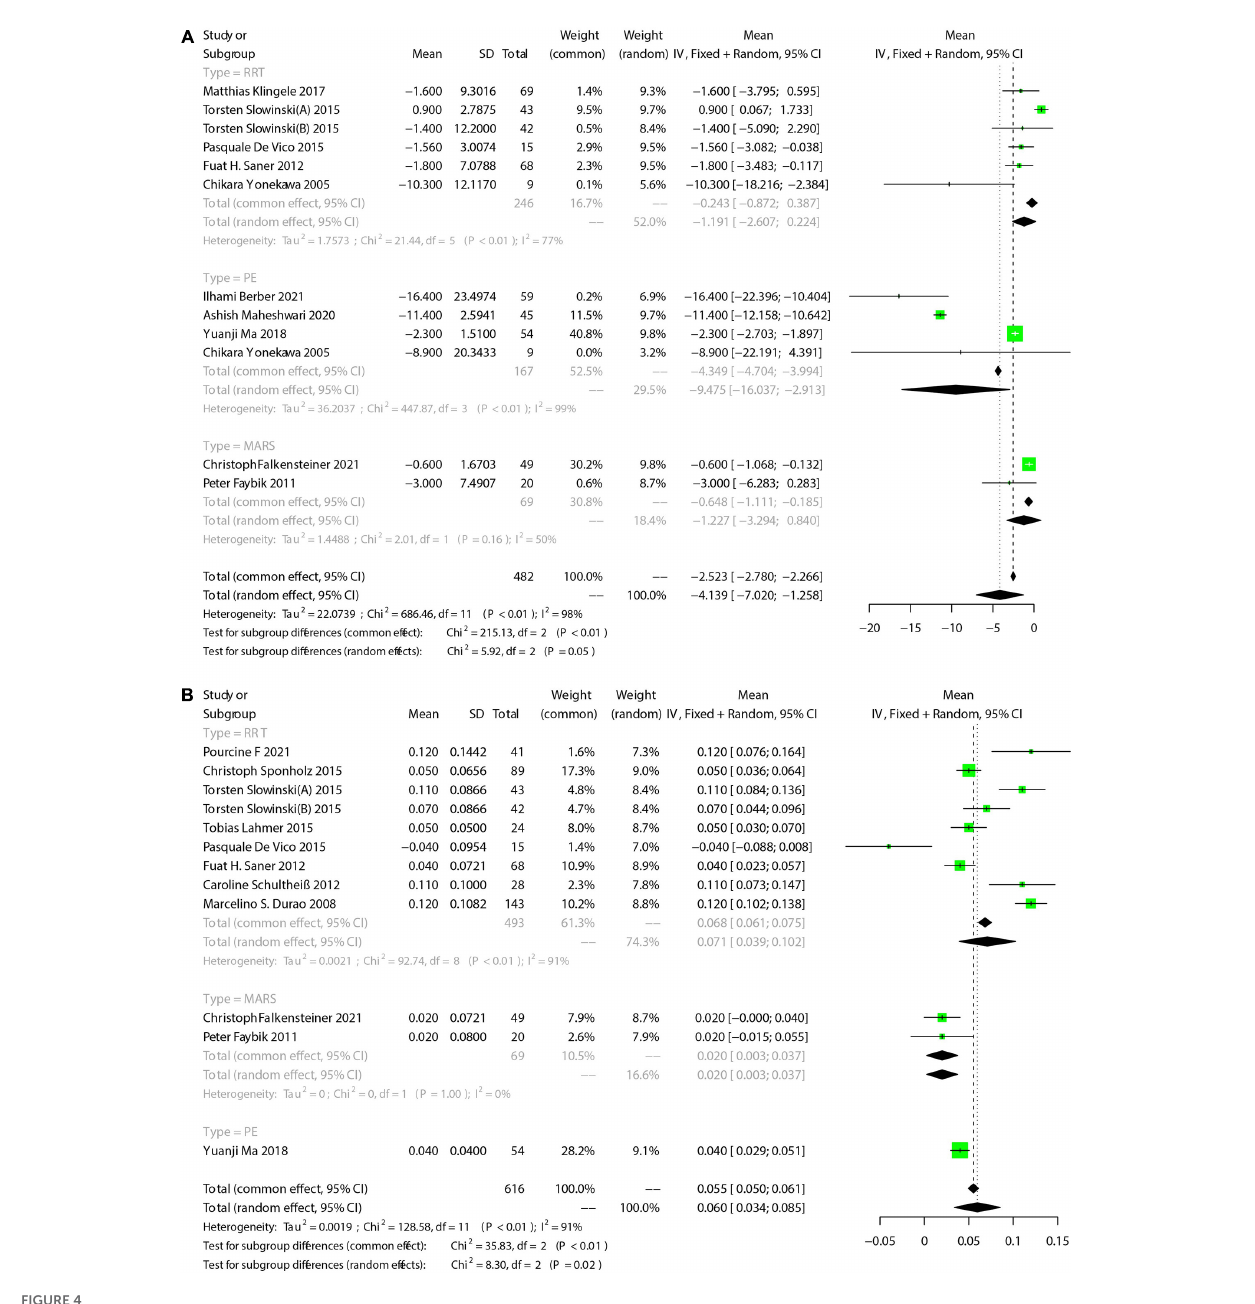
FIGURE4 The pooled rates (95% CI) of TBIL (A) and pH (B) . RRT, renal replacement therapy; MARS, molecular adsorbent recirculation system; PE, plasma exchange; CI, confidence interval; SD, standard deviation; TBIL, total bilirubin; pH, potential of